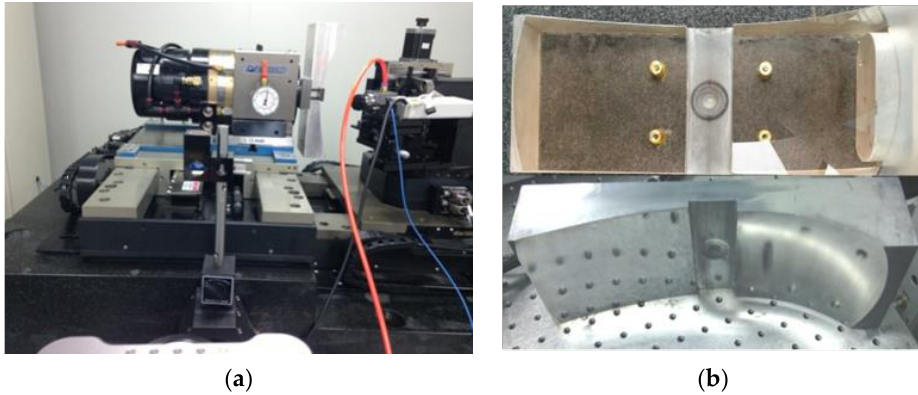
Figure 5. Four − axis machine tool and machined surface workpiece. ( a ) Four − axis machine tool. ( b ) Machined surface workpiece. ( b ) Machined surface